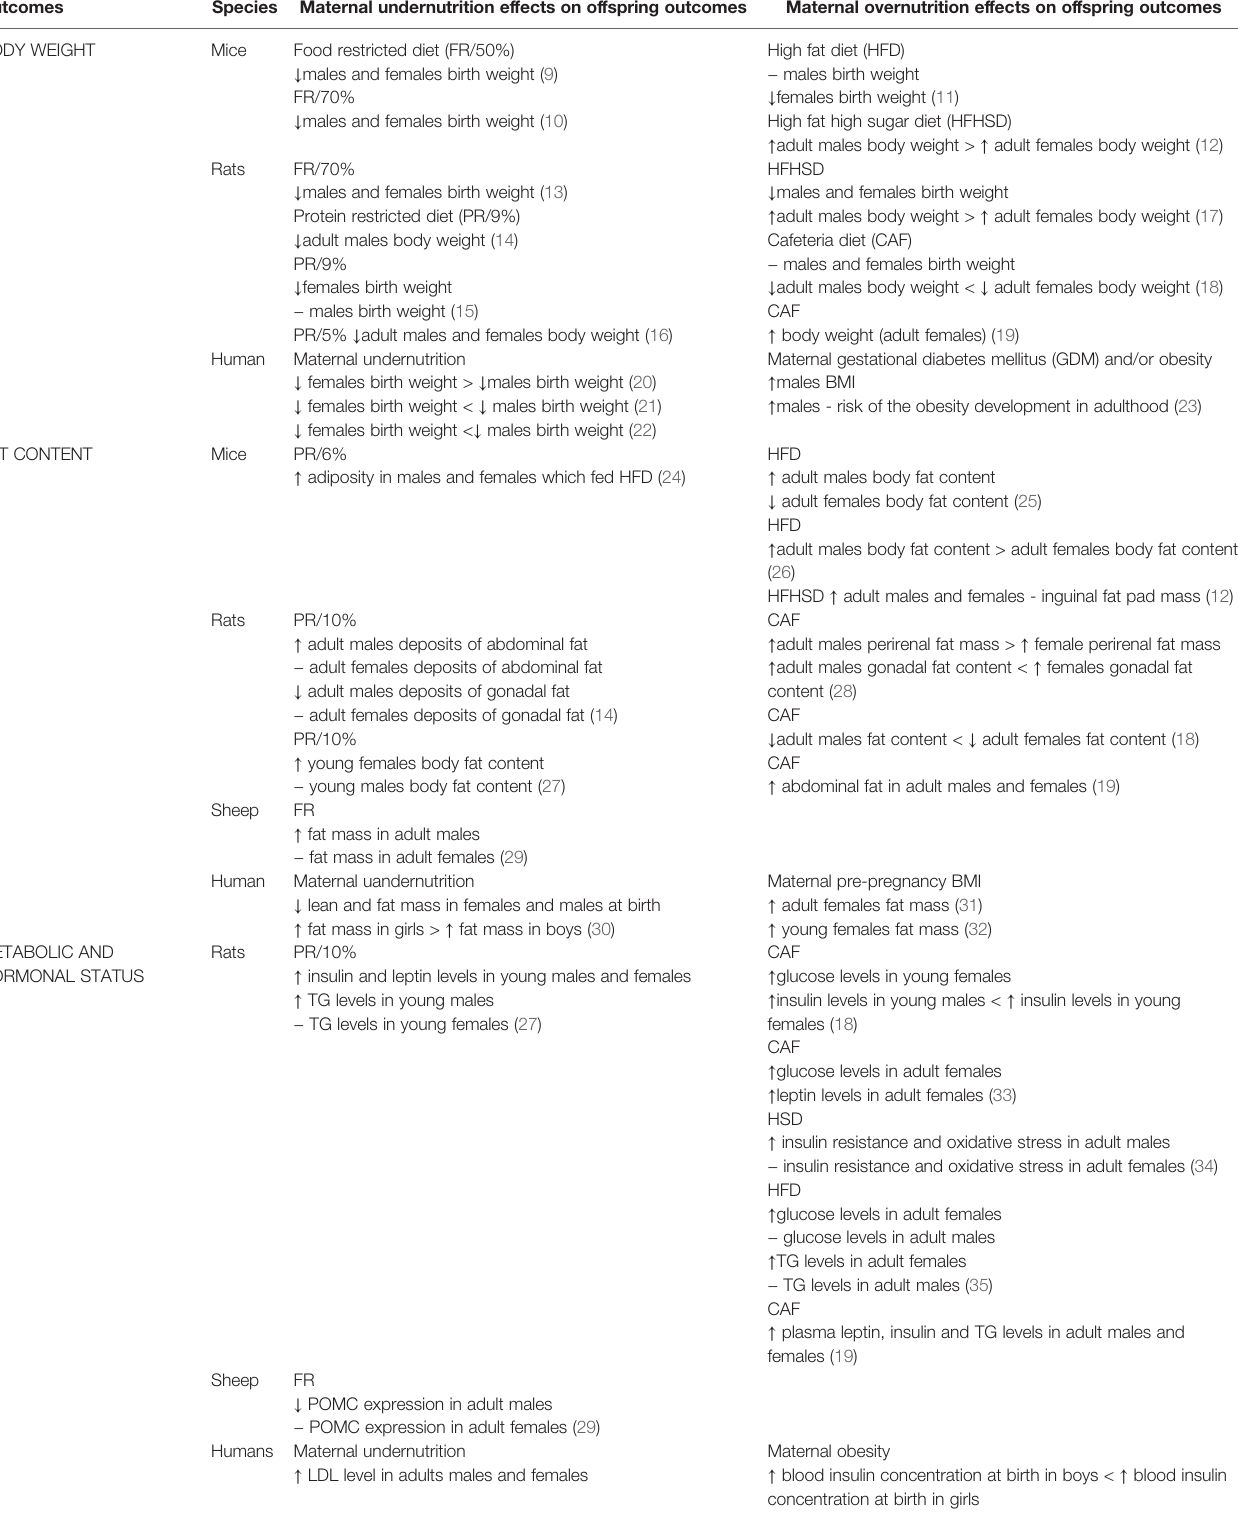
TABLE 1 | Maternal under- and overnutrition induce sex-speci fi c differences in body weight, fat content, metabolic and hormonal status, cardiovascular system and brain and behavioural outcomes in offspring; ↑ - increase; ↓ decrease; - no change.